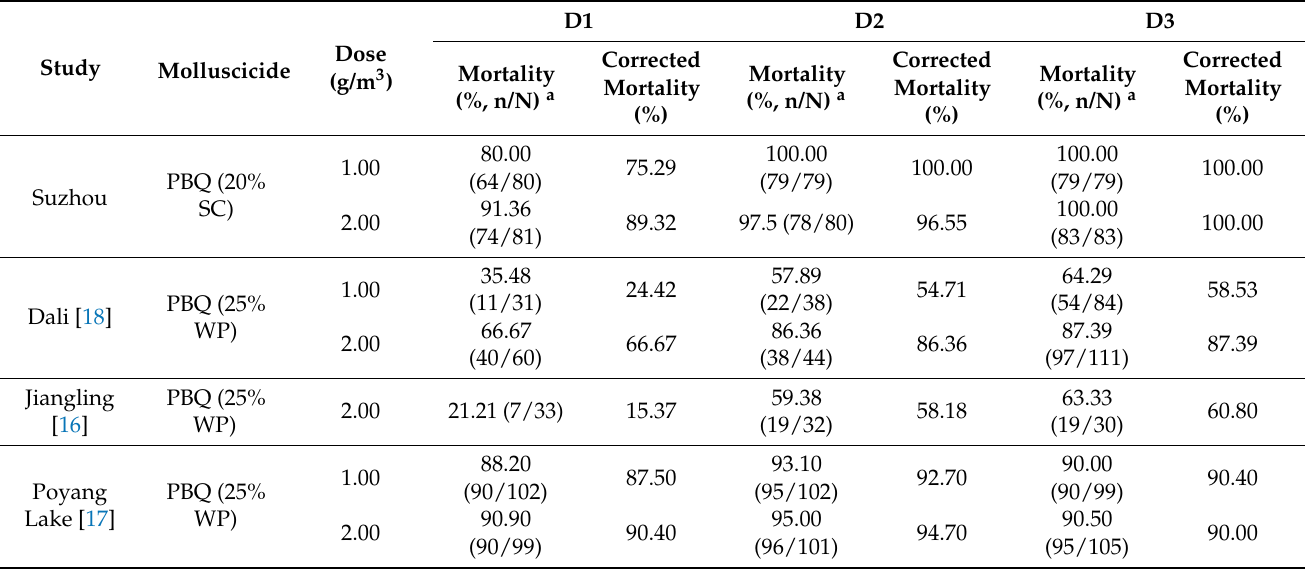
Table 4. Molluscicidal effect of different dosage forms of PBQ in field tests.